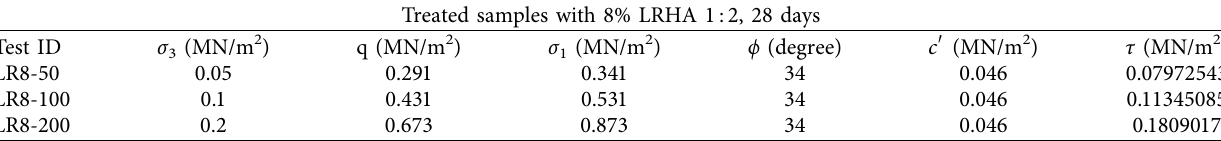
Figure 8: Volumetric changes in three efective confning pressures: LRHA-treated Table 3: LRHA-treated soil (LR8) mechanical parameters.